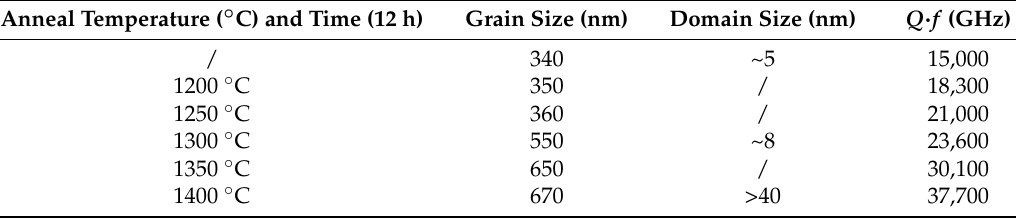
Table 1. Summary of high resolution transmission electron (HRTEM) results and